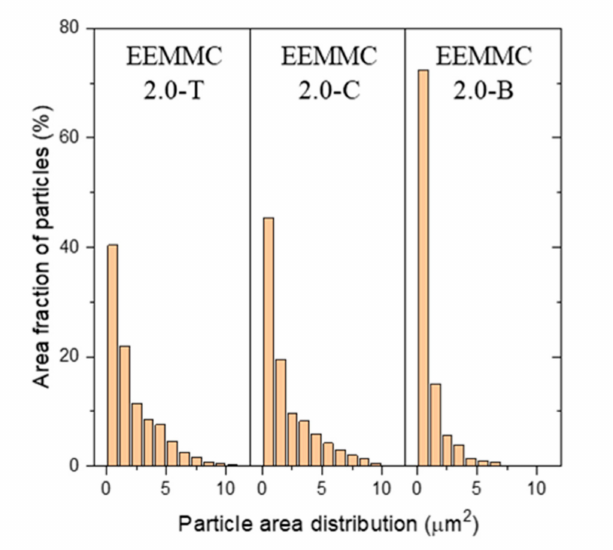
Figure 9. Area distribution of reinforcing particles in EEMMC2.0-T, EEMMC2.0-C, and EEMMC2.0-B. EEMMC1.5-T and EEMMC2.0-T were analyzed by EPMA (Figure 10). In EEMMC1.5-T,